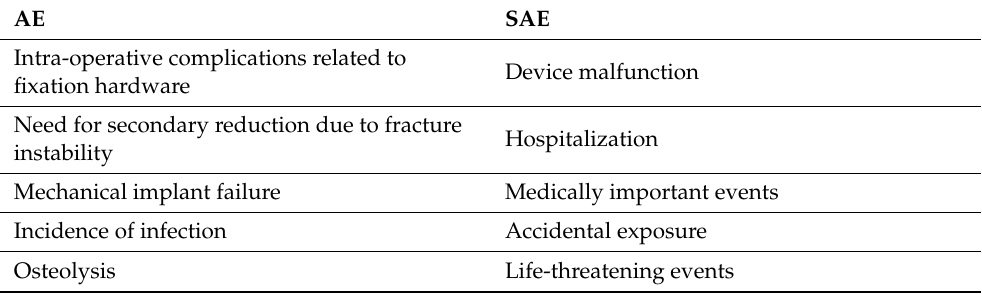
Table 3. Adverse event (AE) and serious adverse event (SAE) specification. AE